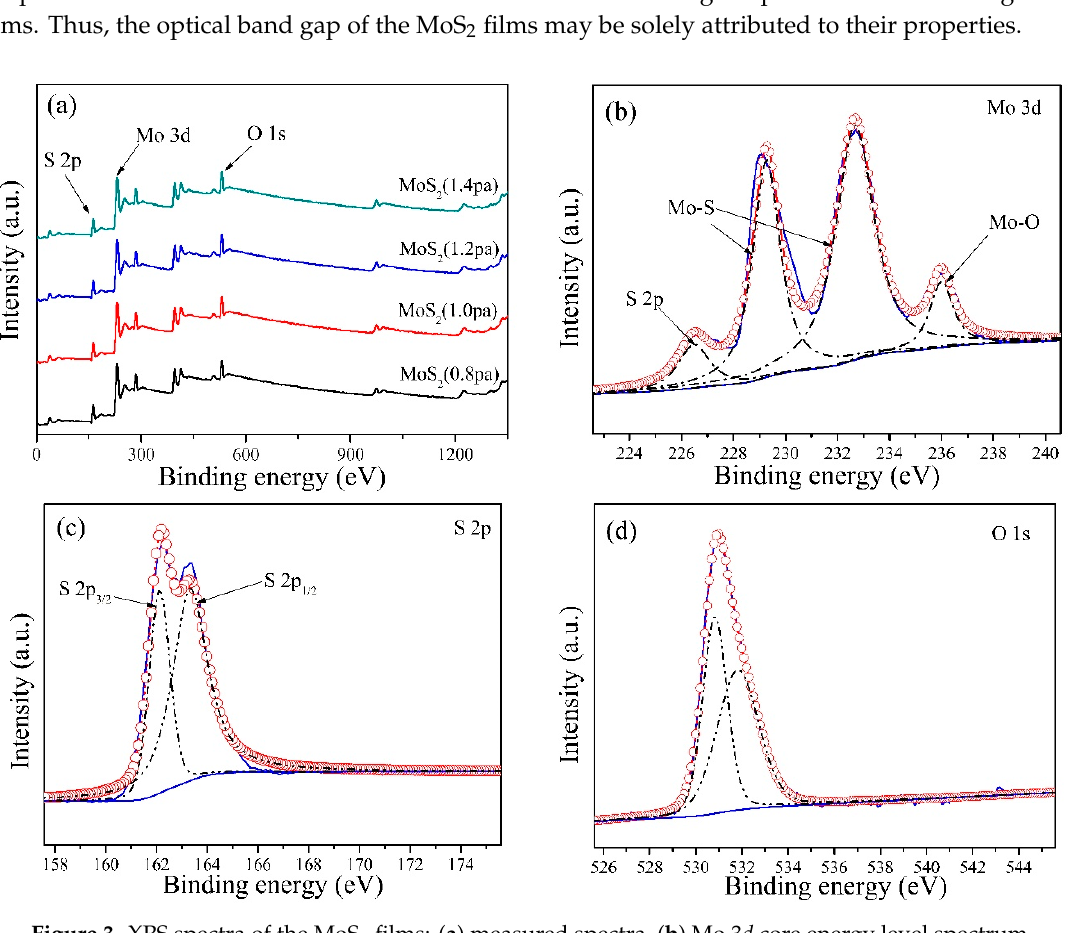
Figure 3. XPS spectra of the MoS 2 films: ( a ) measured spectra, ( b ) Mo 3 d core energy level spectrum, ( c ) S 2 p core energy level spectrum, and ( d ) O 1 s core energy level spectrum.